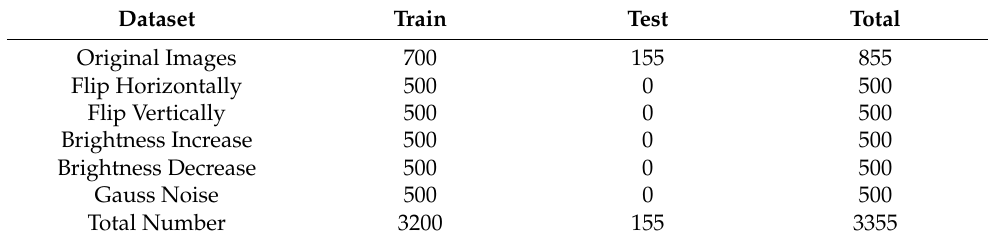
Table 1. Dataset after data enhancement.